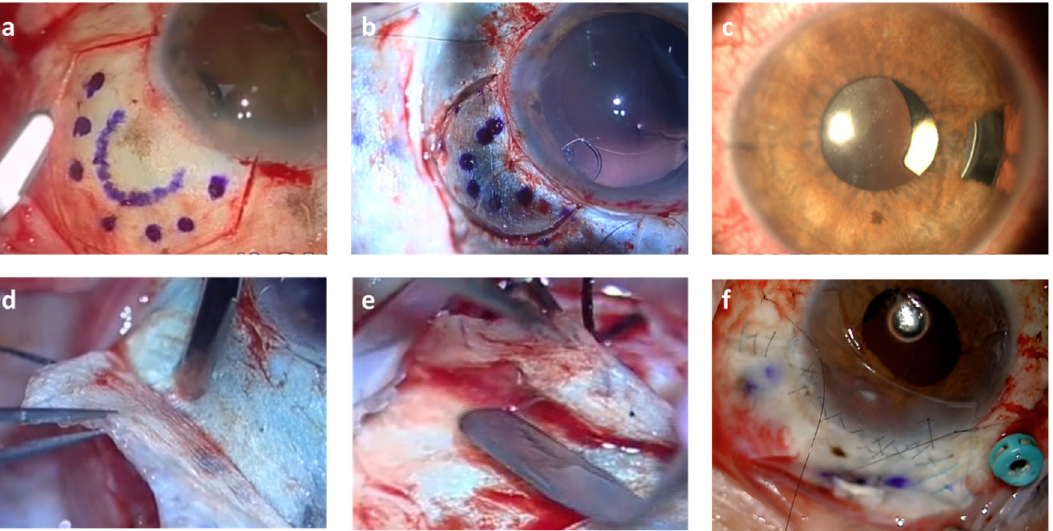
Figure 4. Details of the different surgical techniques, showing: ( a ) ciliary body tumor not involving any muscle with limbus base flap; ( b ) Cionni ring placed before exoresection. ( c ) image of a local exoresection with a Morcher ring with a sector to avoid photophobia; ( d ) vertical fibers in sclera belonging to the muscle tendon and dissection level deepened in sclera to avoid affecting the muscle belly and perforating the flap; ( e ) muscle belly observed after perforating the sclera, fornix based flap; ( f ) autologous sclera and dura mater micropatch.